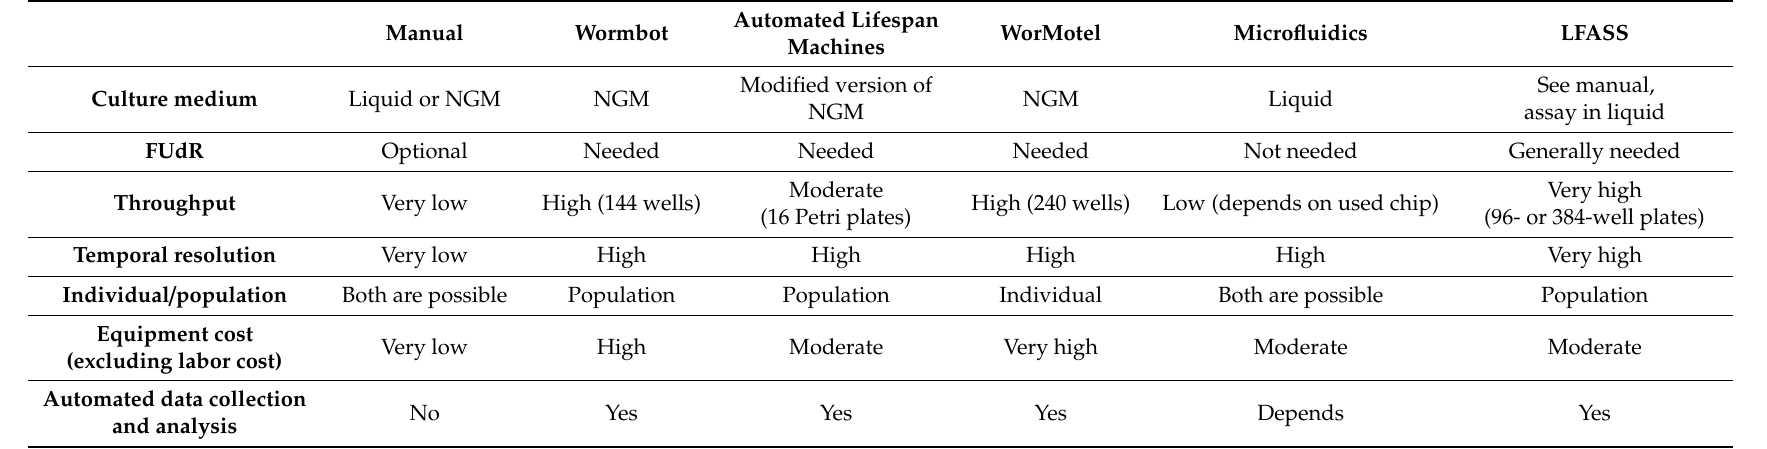
Table 2. A comparison of the various automated lifespan machines for C. elegans. NGM, nematode growth medium; FUdR,